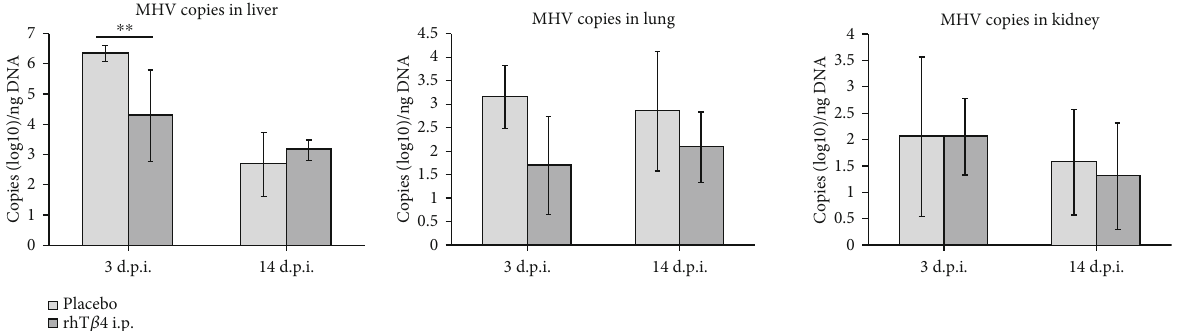
Figure 4: The virus RNA copies of MHV-A59 in the liver, lung, and kidney of mice. The MHV RNA copies in mice tissues of group placebo and rhT β 4 were quanti fi ed real-time qPCR. The unpaired t - test was used to compare two group data. ∗∗ P < 0 : 01 . Table 1: Comparison of cytokine levels in each